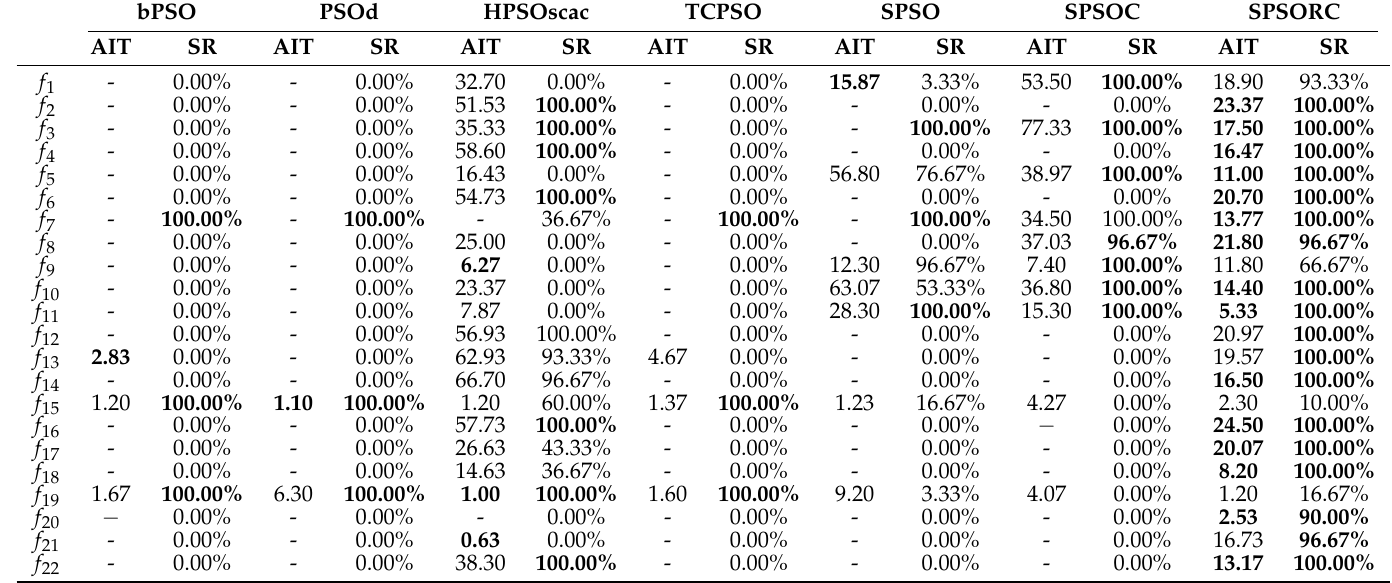
Table 9. Success rate and average iteration